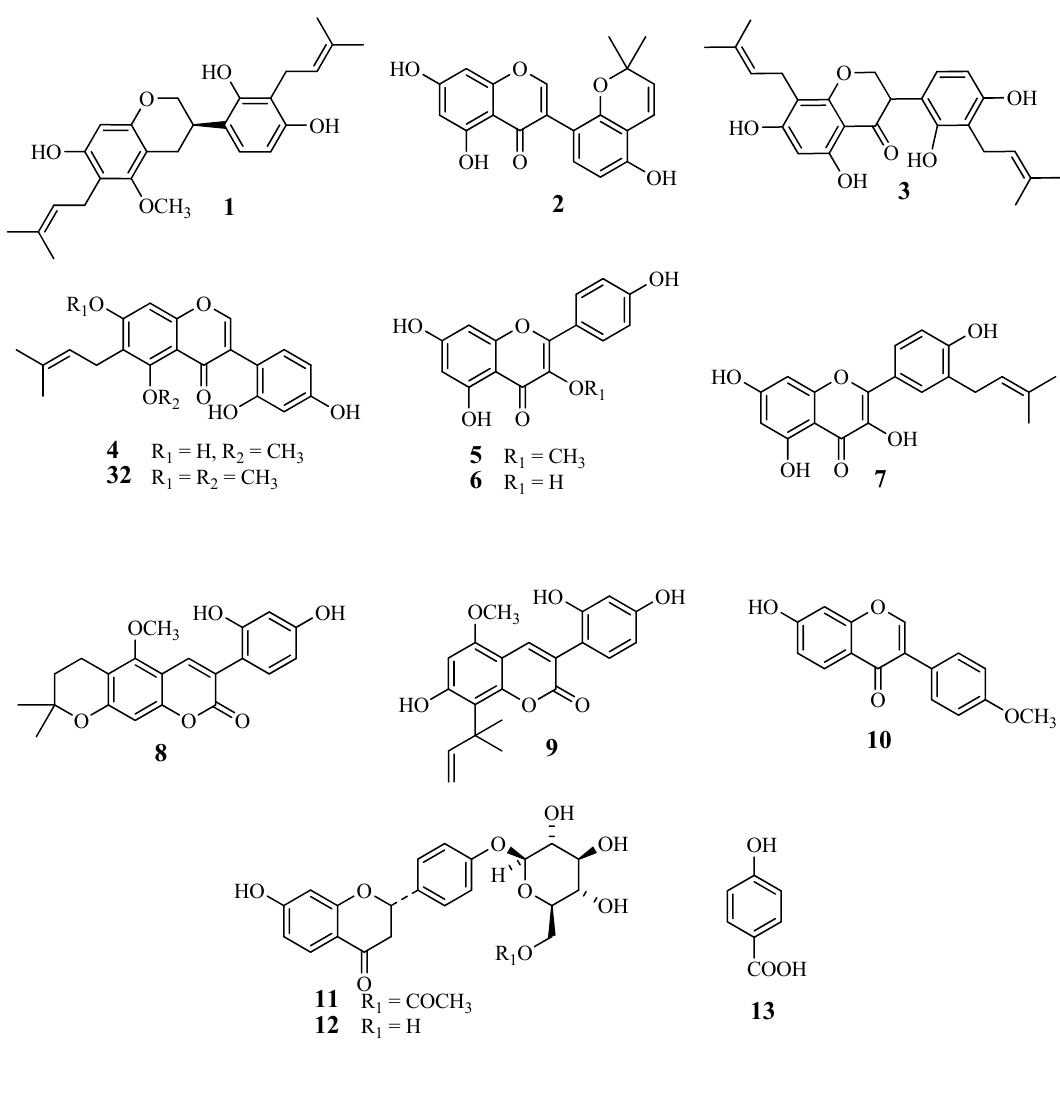
Figure 1. Chemical structures of compounds 1 ‒ 13 and 32 isolated from root and stolon of Glycyrrhiza uralensis